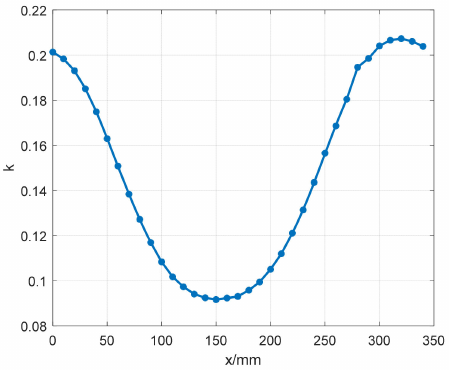
Figure 7. Variation curve of coupling coefficient k .